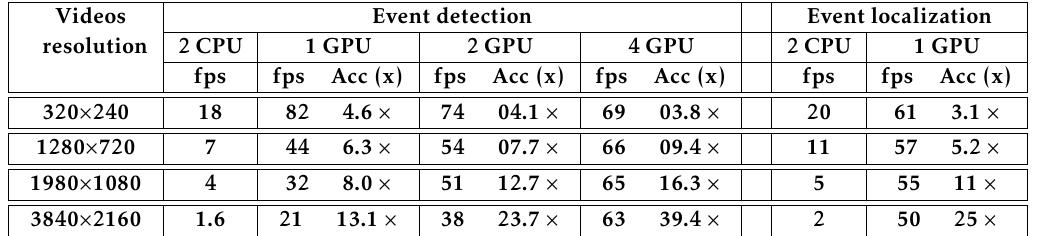
Table 2. Performance of event detection and localization on GPUs: CPU Intel i5 and GPU GTX 580